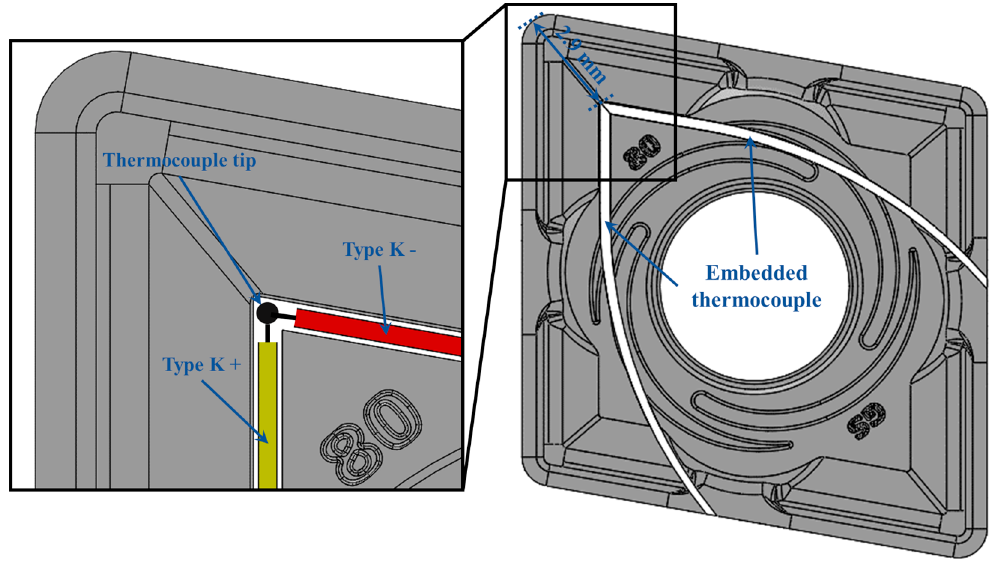
Figure 1. Schematic representation of the K-type embedded thermocouple WC-Co insert.